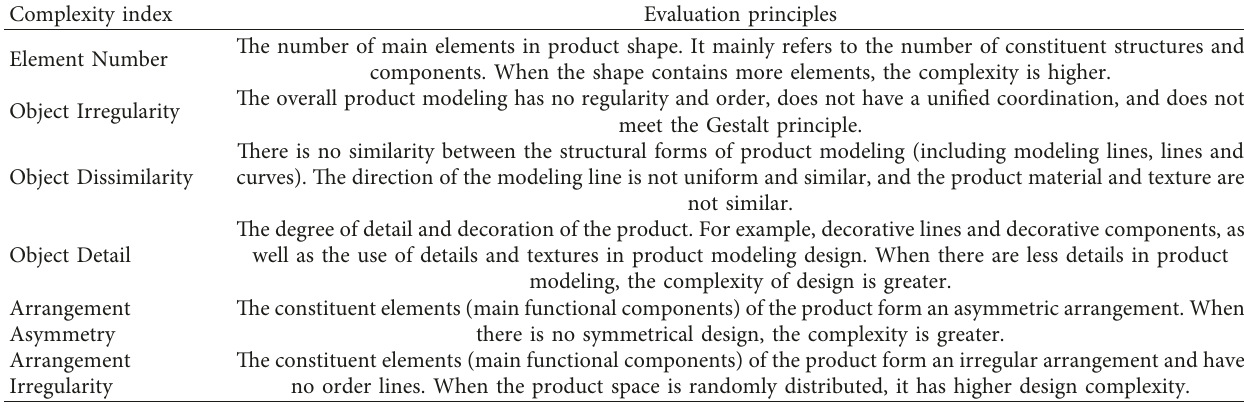
Table 1: Complexity induces and their evaluation